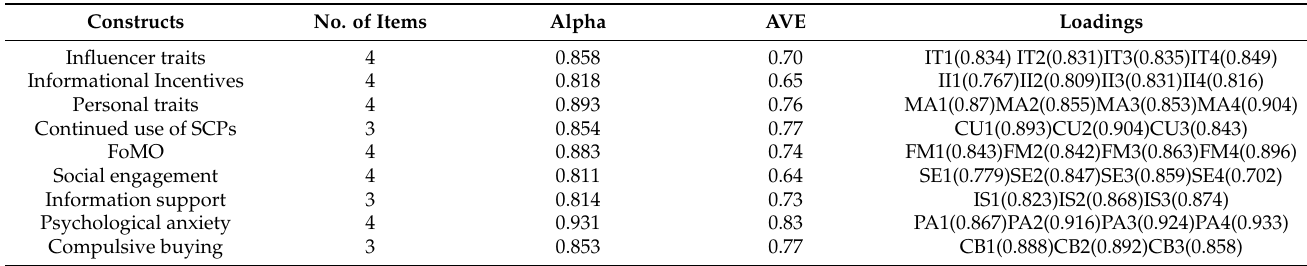
Table 5. Reliability analysis.